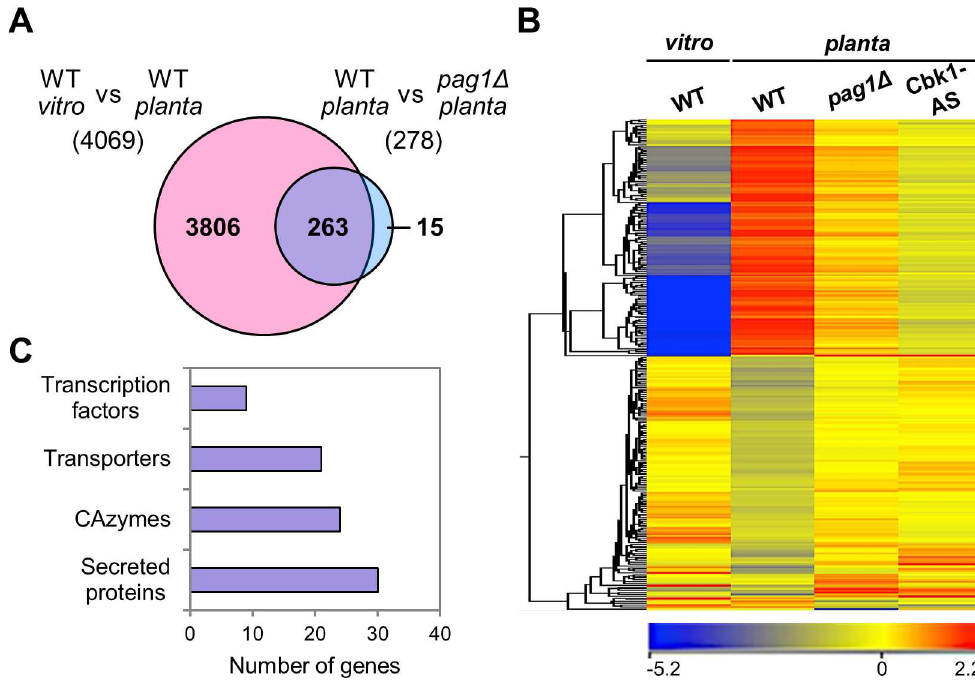
Fig 6. The MOR components of C . orbiculare are responsible for the expression of the plant-signal- induced genes. (A) Venn diagram illustrating overlaps betweennumberof upregulatedgenes (red) during appressorium formation in planta comparedwith in vitro and downregulated genes (blue) in copag1 Δ compared with the wild type, both incubated in planta .(B) Hierarchical clusteringheatmapof gene expressionshowingthe differentially regulatedgenes in copag1 Δ comparedwith the wild type, both incubated in planta . For inhibitingof CoCbk1activity of CoCbk1-AS, 0.5 μ M 1NA-PP1 was appliedat 3 h after inoculation. Differential expressionof each gene is indicatedin color (red: induced, blue: repressed; numbers belowscale: fold change). (C) Number of plant-signal-inducedgenes that were downregulated in copag1 Δ compared with the wild type, both incubated in planta ,in four